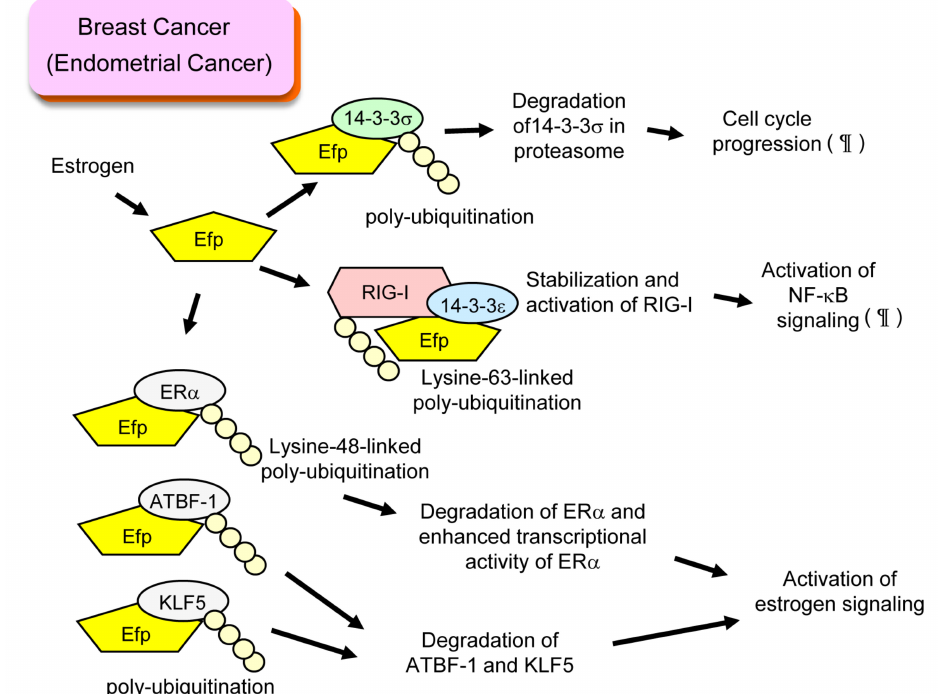
Figure 1. Roles of Efp in breast cancer and endometrial cancer. In breast cancer cells, Efp is tran- scriptionally induced by estrogen and contributes to cancer progression with several mechanisms. ¶: Mechanisms also suggested in endometrial